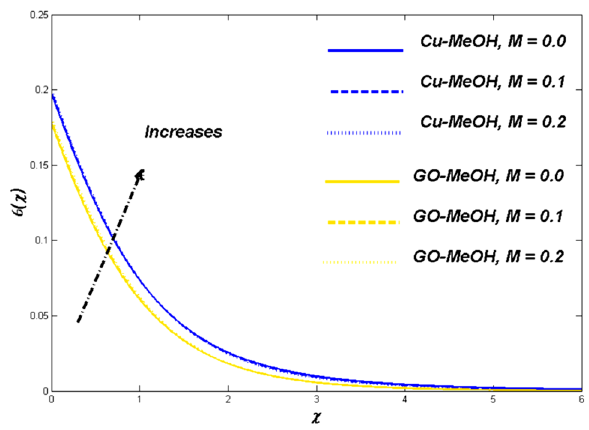
Figure 8. Temperature variation versus M .